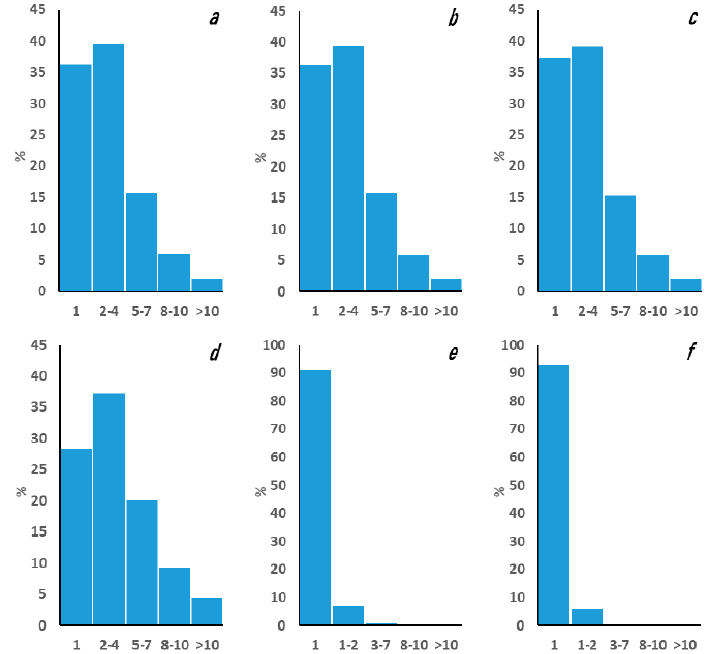
Figure 8. Frequency of annual forest wildfires (%) in relation to total bird richness in Bolivia ( a ) and only KBA ( b ), threatened bird species in Bolivia ( c ) and only KBA ( d ), endemic bird species in Bolivia ( e ) and only KBA ( f ).